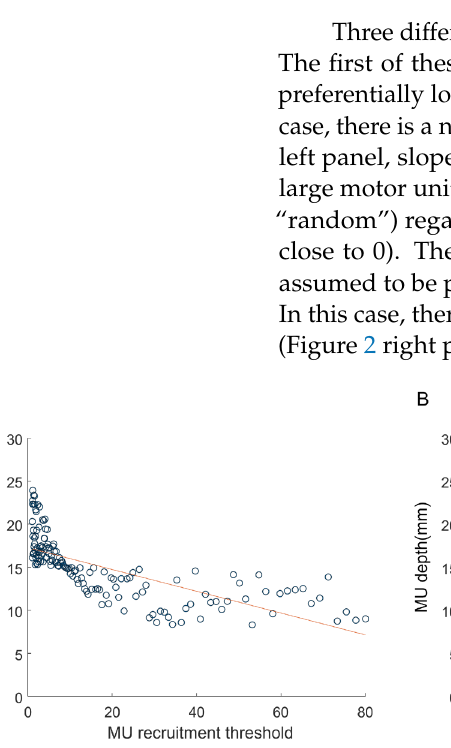
Figure 1. The cylindrical muscle model and electrode for surface EMG simulation. Left panel: the tripole model and the position of the electrode with respect to the cylinder parameters. Right panel: the cross-section of the cylindrical model showing muscle and skin fat layers.